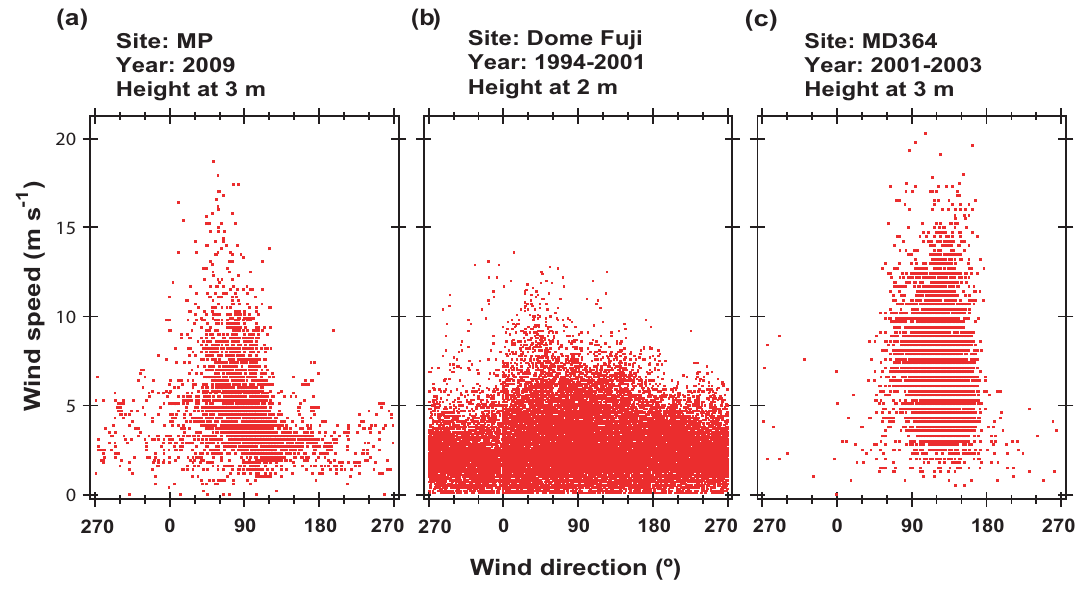
Fig. 6. Relationship between wind speed and direction at the three AWS sites along the JASE traverse. (a) Data at MP during the year 2009. The observational data is from the AWS JASE2007. Data selected at three hourly intervals were used. Of the measured events, 6% have wind speeds of more than 10ms − 1 , with an average wind direction of 70 ◦ (±24 ◦ , standard deviation). (b) Data at Dome Fuji during the years from 1994 to 2001 (Takahashi et al., 2004). Data at hourly intervals were used. Of the measured events, 1% has wind speeds of more than 8ms − 1 , with an average wind direction of 53 ◦ (±48 ◦ ). (c) Data at MD364 during the years from 2001 to 2003 (Keller et al., 2010). Data at three hourly intervals were used. Of the measured events, 14% have wind speeds of more than 10ms − 1 , with an average wind direction of 120 ◦ (±22 ◦